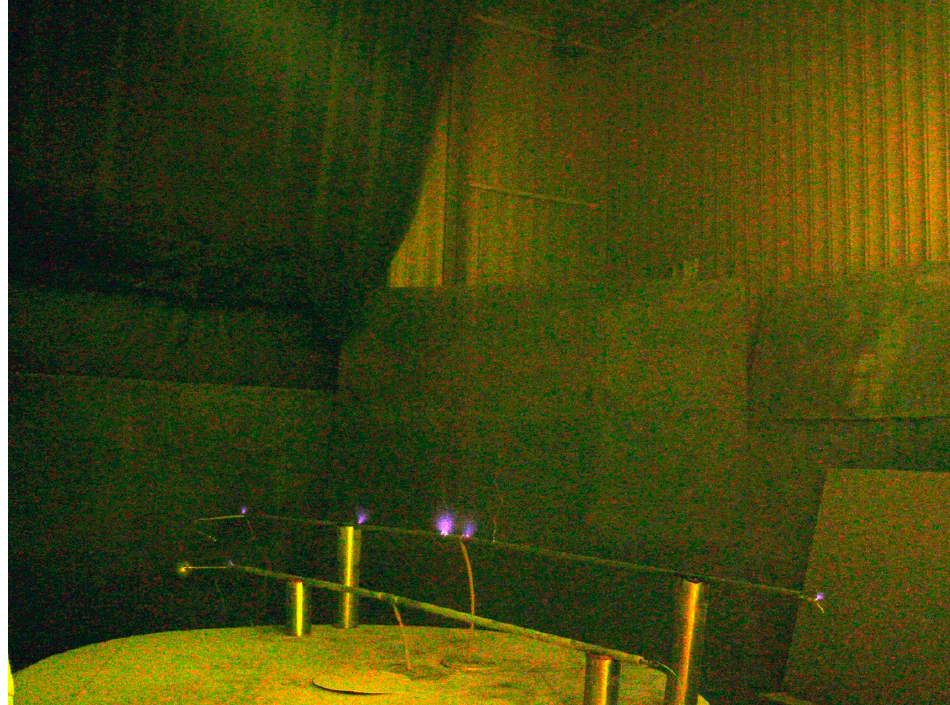
Figure 4. Upward streamer discharges from the grounded cylinder model element. The characteristic oscillograms of the current impulse of powerful streamer corona flash and the corresponding induced electromagnetic effects (induced current) on the close rod or elongated model element are shown in Figure 5. The discharge current was